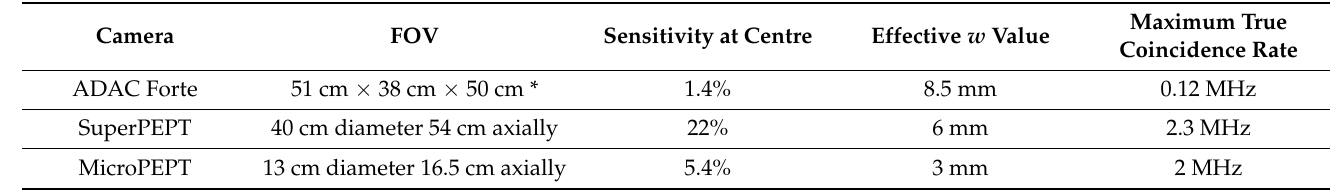
Table 1. Comparison of the three positron